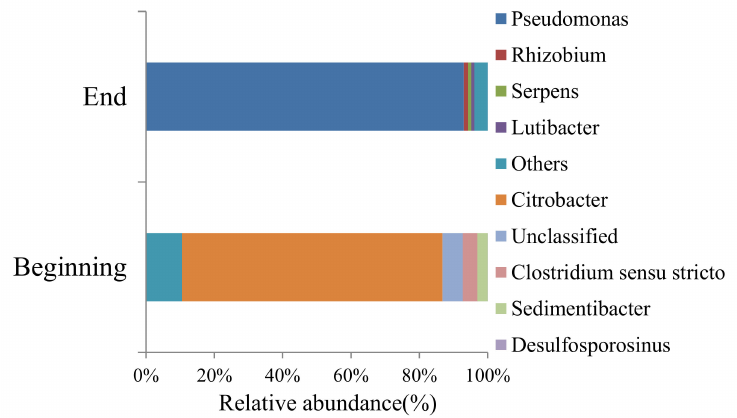
Figure 2. The microbes strain at the beginning and at the end of the